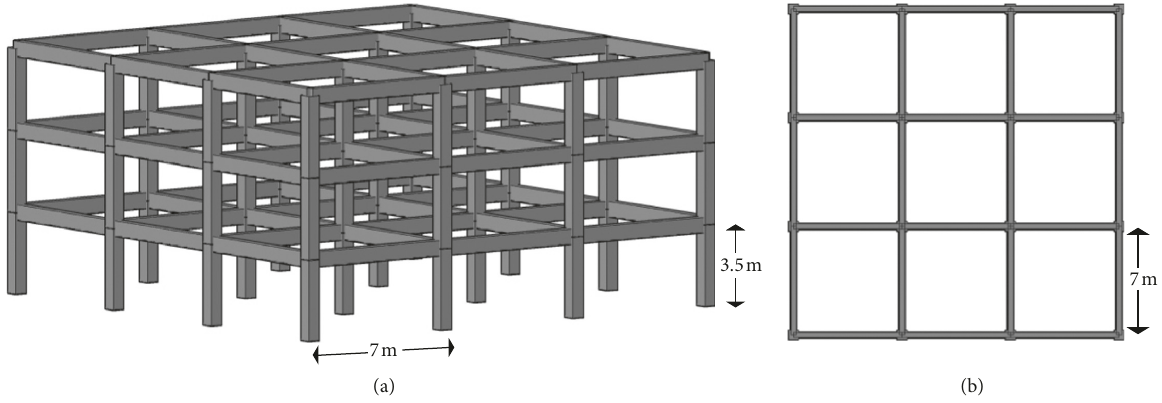
Figure 4: Model RC-3, with 3 objective sections. (a) Three-dimensional view. (b) Plan view.